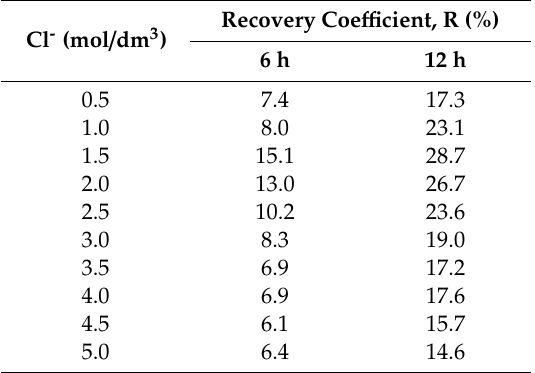
Figure 6. Change in concentration of copper(II) in receiving phase over time depending on concentration of chloride anions in feed phase. The volumetric flow rate is 3.0 cm 3 / min. Feed phase: CuCl 2 concentration = 0.1 mol / dm 3 , chloride concentration = 0.5–5.0 mol / dm 3 ; receiving phase: demineralized water; and membrane: CTA-ONPOE-TRIA-10. The composition of the membrane is given in Table 2. Temperature: 20 ± 0.5 ◦ C. Table 5. Recovery coe ffi cient (R%) of Cu(II) ions after 6 and 12 h depending on concentration of chloride anions in feed phase.